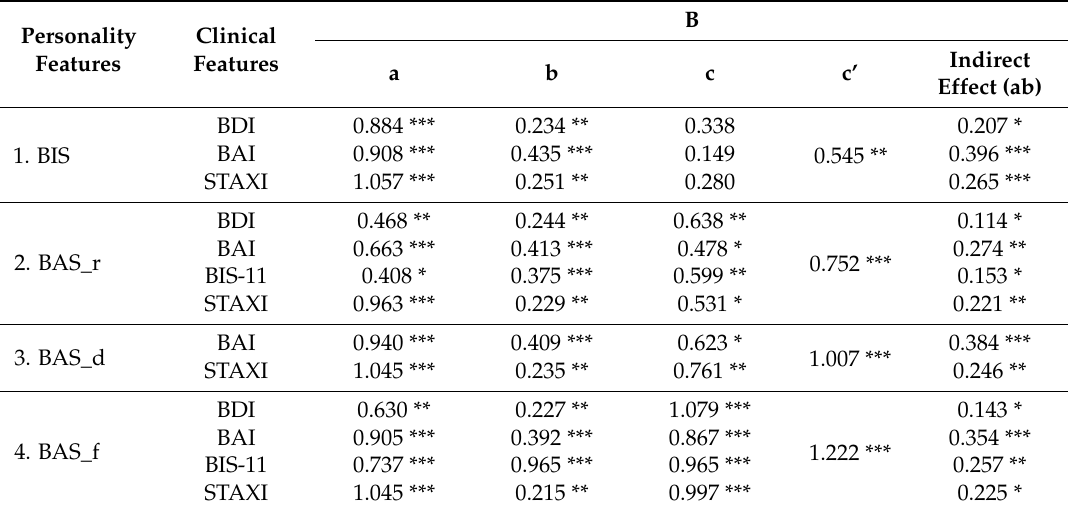
Table 4. Regression results for simple mediation in girls.